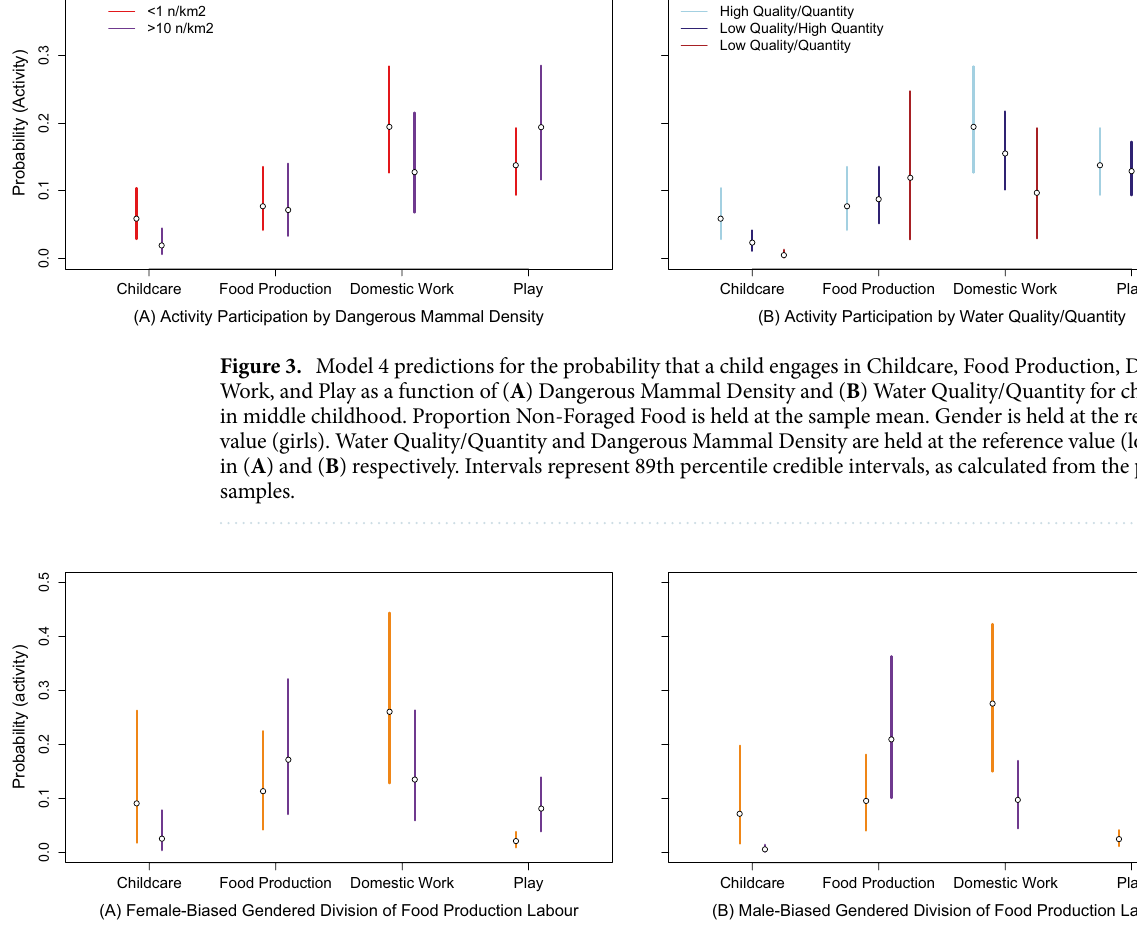
Figure 4. Model 5 predictions for the probability that adolescent girls and boys engage in Childcare, Food Production, Domestic Work, and Play in societies where ( A ) the Adult Gendered Division of Food Production Labour is biased towards women’s contributions (set at − 0.5) and ( B ) biased towards men’s contributions (set at 1). Proportion of Non-Foraged Food is held at the sample mean. Intervals represent 89th percentile credible intervals, as calculated from the posterior